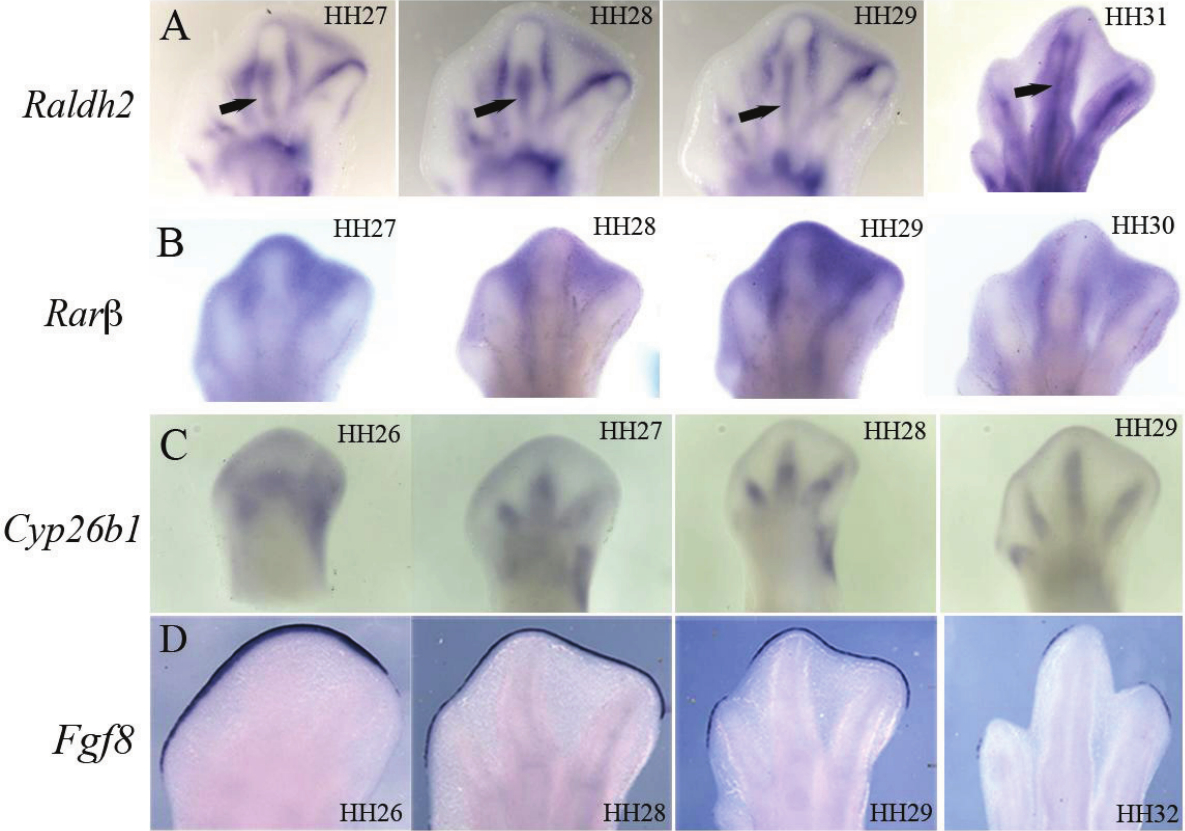
Figure 2. Expression of Raldh2 , Rarβ , Cyp26b1 and Fgf8 in developing chick hind limbs. Whole mount in situ hybridization of Raldh2 , Rarβ , Cyp26b1 and Fgf8. ( A) Raldh2 expression pattern at stages 27 – 29HH and 31HH. ( B) Rarβ expression pattern at stages 27 – 30HH. ( C) Cyp26b1 expression pattern at developing stages 26 – 29HH. ( D)